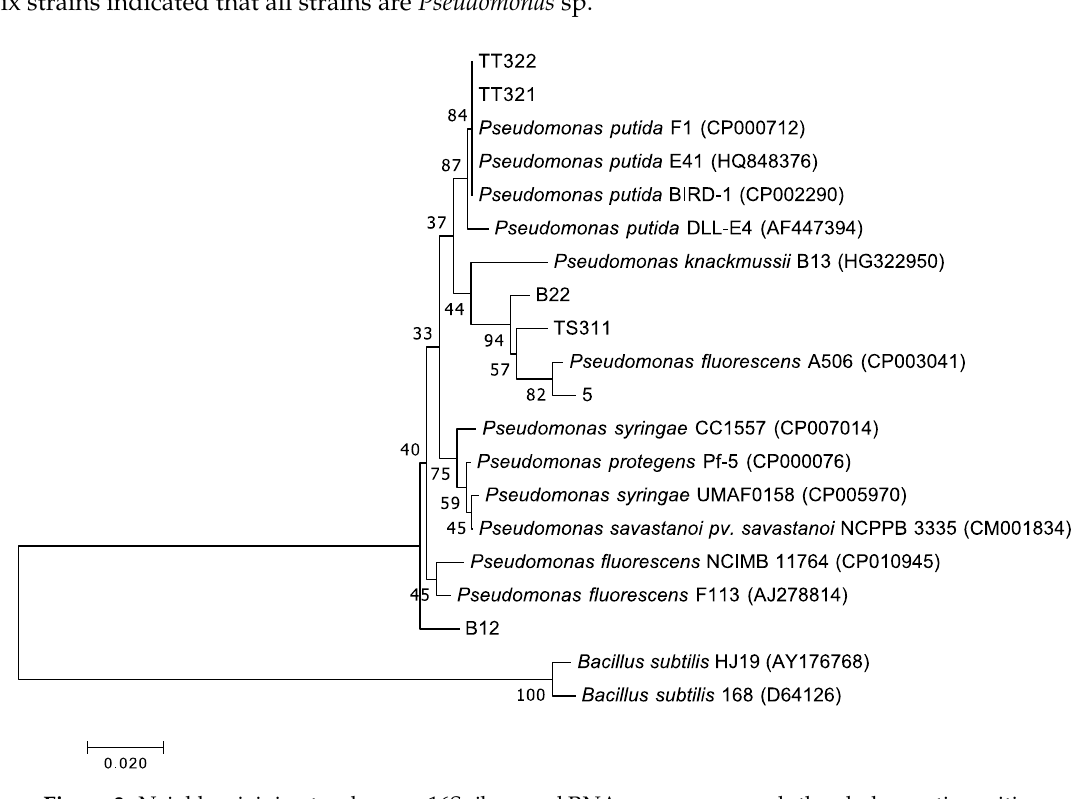
Figure 3. Neighbor-joining tree base on 16S ribosomal RNA sequences reveals the phylogenetic position of six isolates and representatives of several other reference sequences. Six strains (B12, B22, 5, TS311, TT321, and TT322) were isolated from three water samples of L. vannamei are Pseudomonas sp.